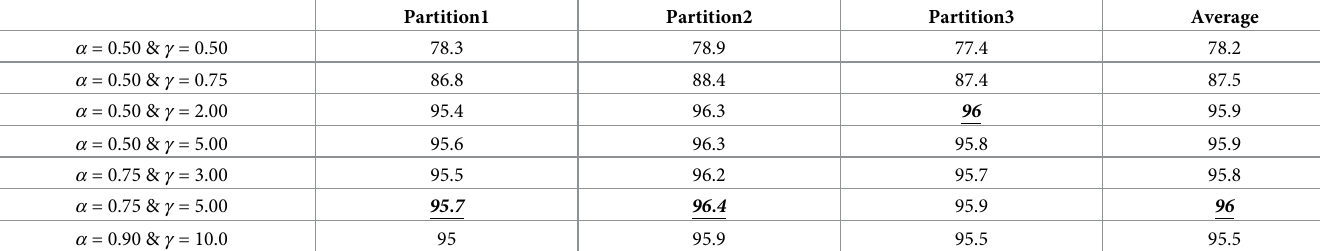
Partition1 Partition2 Average